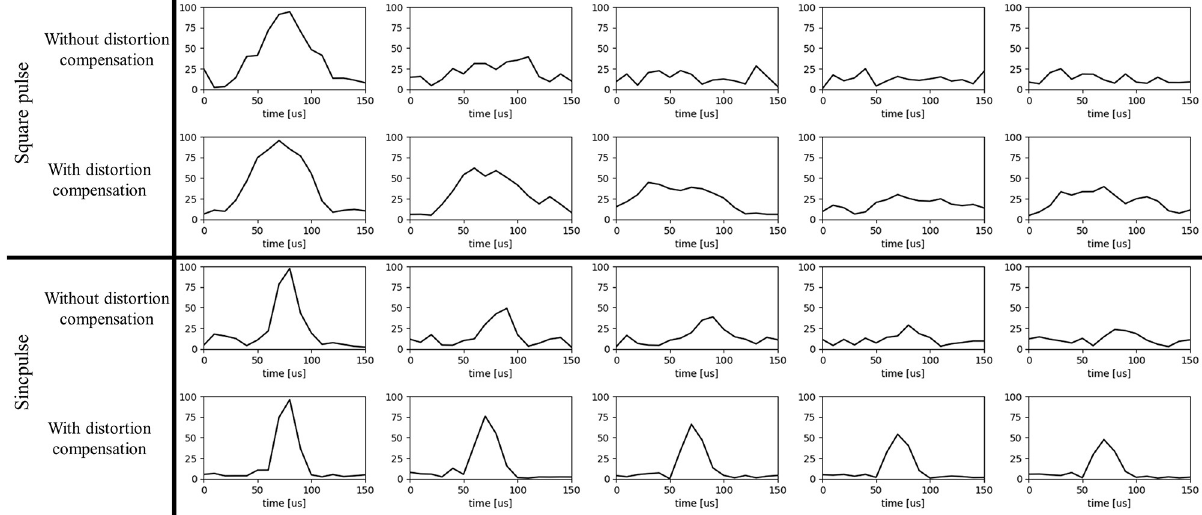
Fig 10. 1 H 25 th , 50 th , 75 th , 100 th , and 125 th echoes from a train of 1000 echoes, of water obtained using square pulse (top row), compensated square pulse (second row), sinc pulse with 90 kHz bandwidth (third row), and compensated sinc pulse, 90 kHz bandwidth, n = 37 (bottom row).